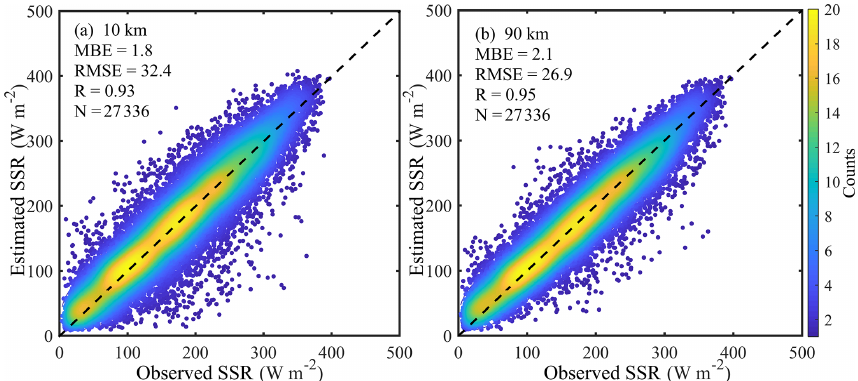
Figure 7. Comparisons of our estimated daily SSR at spatial resolutions of (a) 10km and (b) 90km with observed SSR at 90 CMA radiation stations.